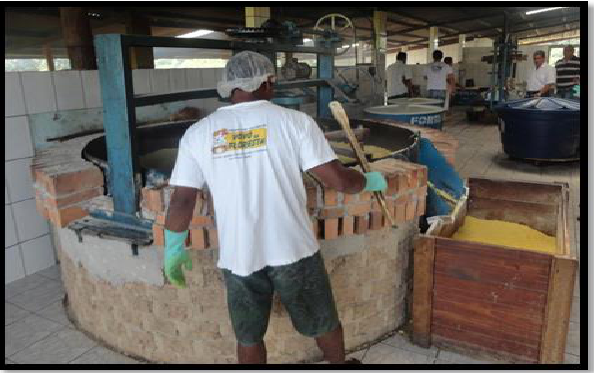
Figura 5: Processo de Torragem da Farinha).